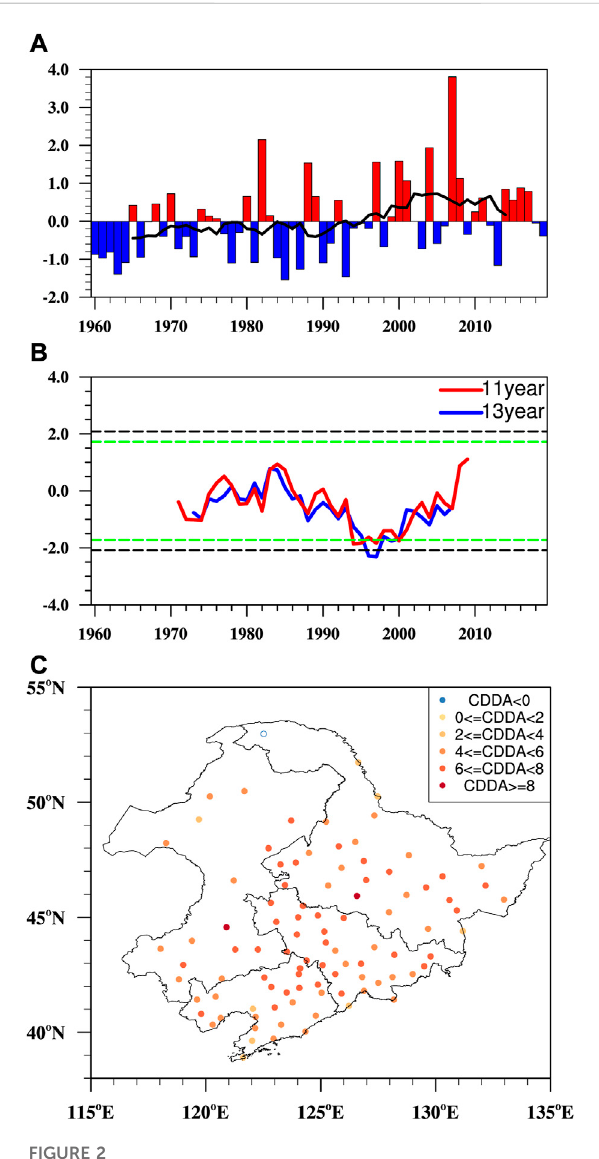
FIGURE 2 (A) The normalized time series of the CDDA index (bar) and the corresponding 11-year running mean (line) during 1960 − 2019. (B) The moving t -test of the CDDA index during 1960 − 2019, with window lengths of 11-year (red line) and 13-year (blue line). The green (black) horizontal dashed lines indicate the 90% (95%) con fi dence level. (C) Regression of summer CDDA anomalies (unit: day) against thenormalizedCDDAindexduring1960 − 2019.Thesoliddotsindicate that the anomalies are signi fi cant at the 95% con fi dence